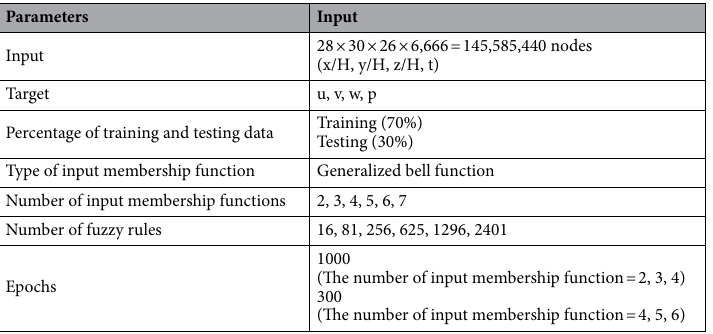
Table 2. ANFIS parameters used for convergence and sensitivity test.